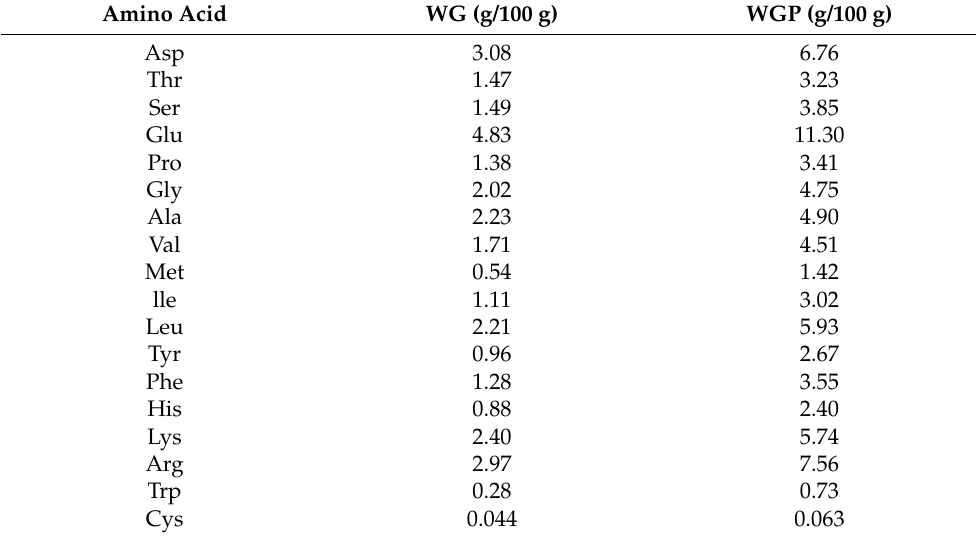
Table 2. Amino acid compositions of the WG and